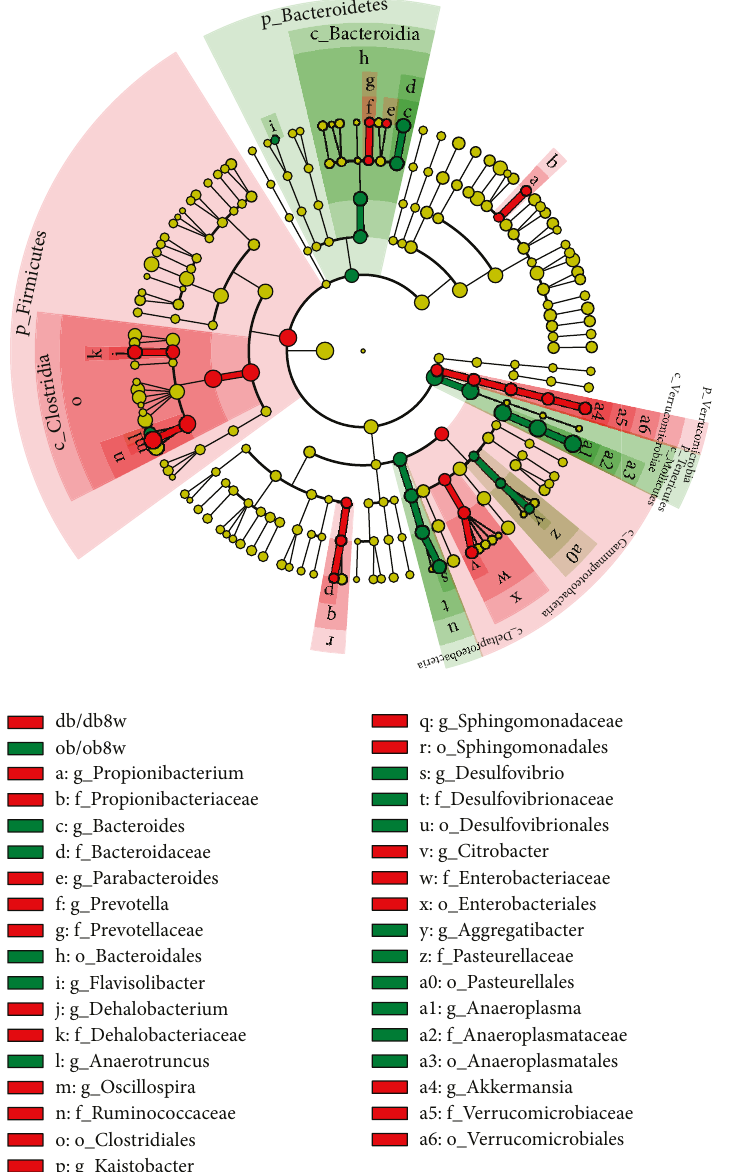
Figure 6: Cladogram representing a signi fi cantly high abundance of taxa in the gut microbiota of ob/ob and db/db mice at 8 weeks of